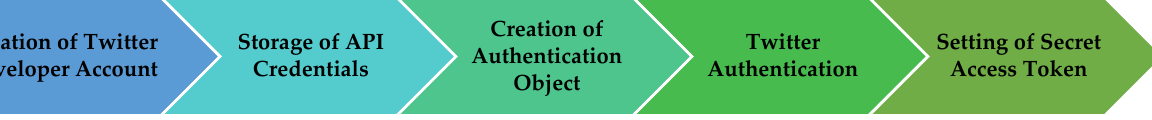
Figure 1. Twitter API access procedure.